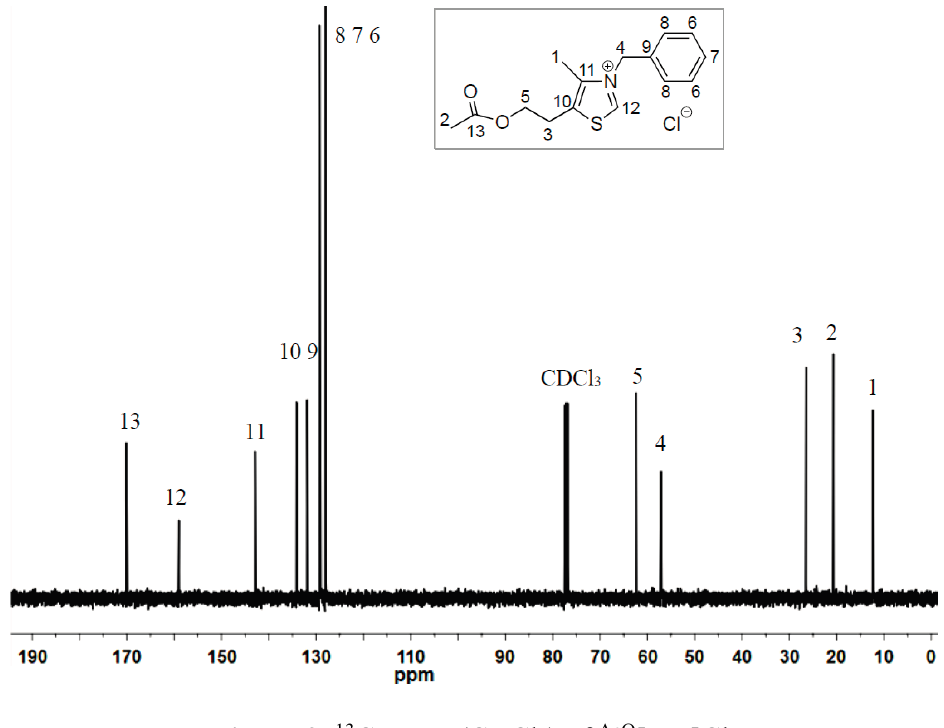
Figure 2. 13 C NMR (CDCl 3 ) of AcO [TM]Cl.